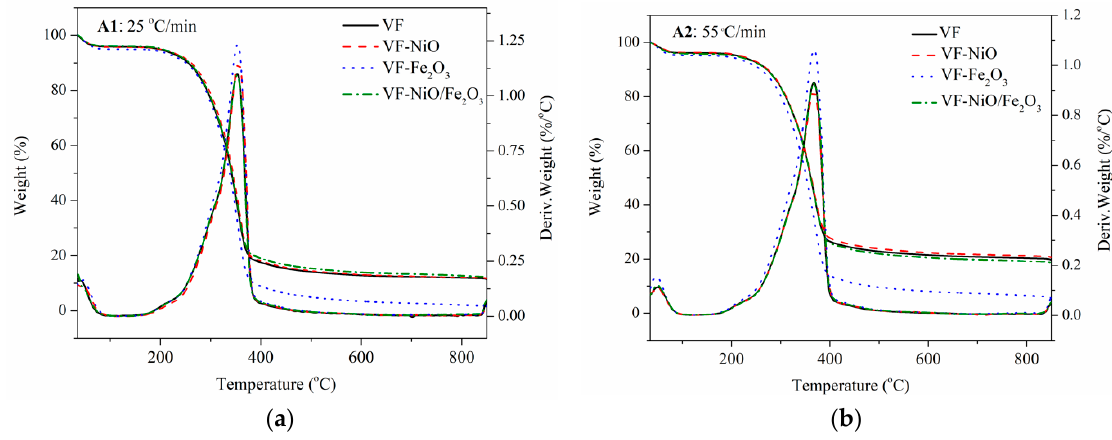
Figure 2. TG and DTG curves of Vernicia fordii wood samples at two different heating rates: 25 °C/min ( a ) and 55 °C/min ( b ).